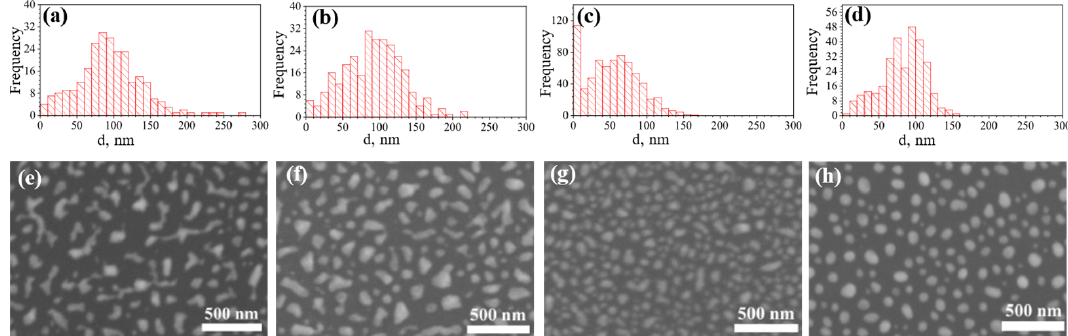
Figure 2. The diameter ( d ) distribution of AgNPs and SEM images of AgNP/TiO 2 structures obtained by SSD process ( T a = 400 °C, h Ag = 10 nm) using different t a : ( a , e ) 10 min; ( b , f ) 20 min; ( c , g ) 40 min; ( d , h ) 60 min.